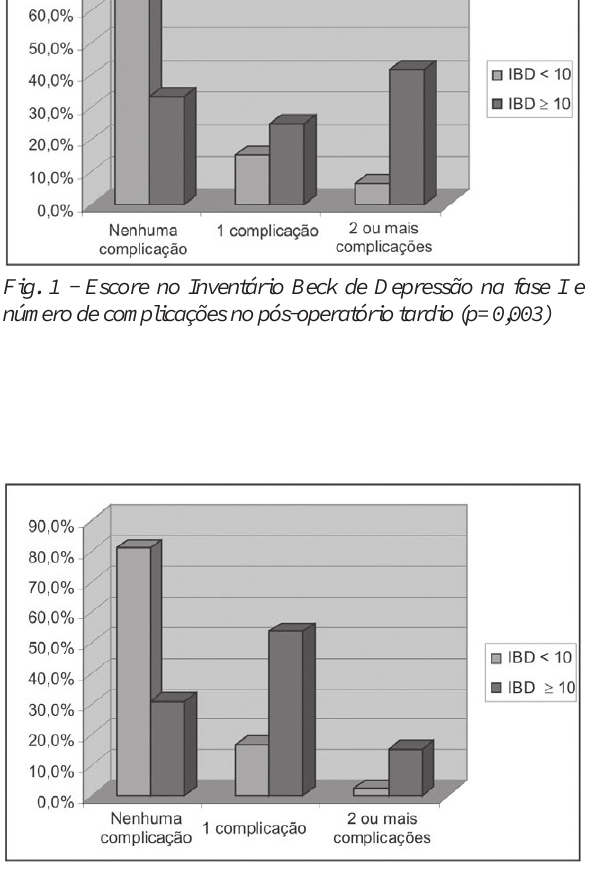
Fig. 2 - Escore no Inventário Beck de Depressão na fase II e número de complicações no pós-operatório tardio